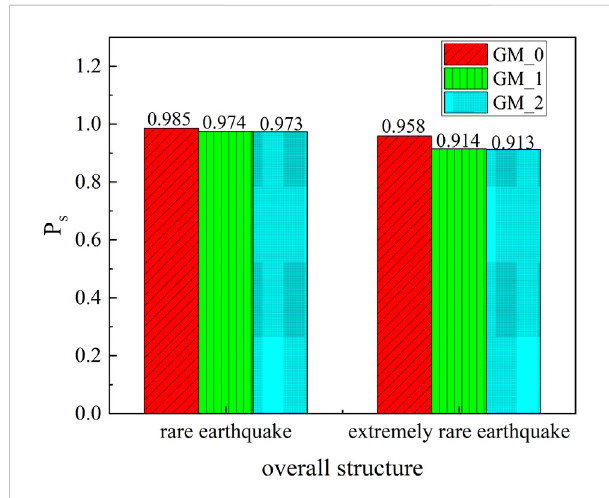
Comparison of reliability probability of the overall structure.